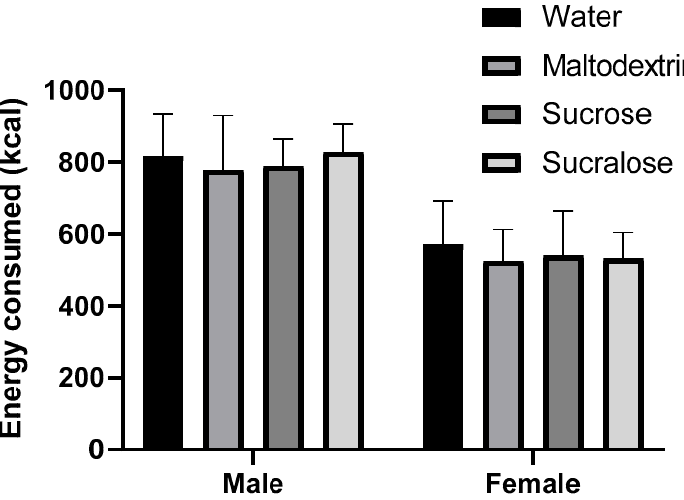
Figure 3. Energy consumed (kcal) during the test meal in male and female panelists. Bars represent mean plus SEM.